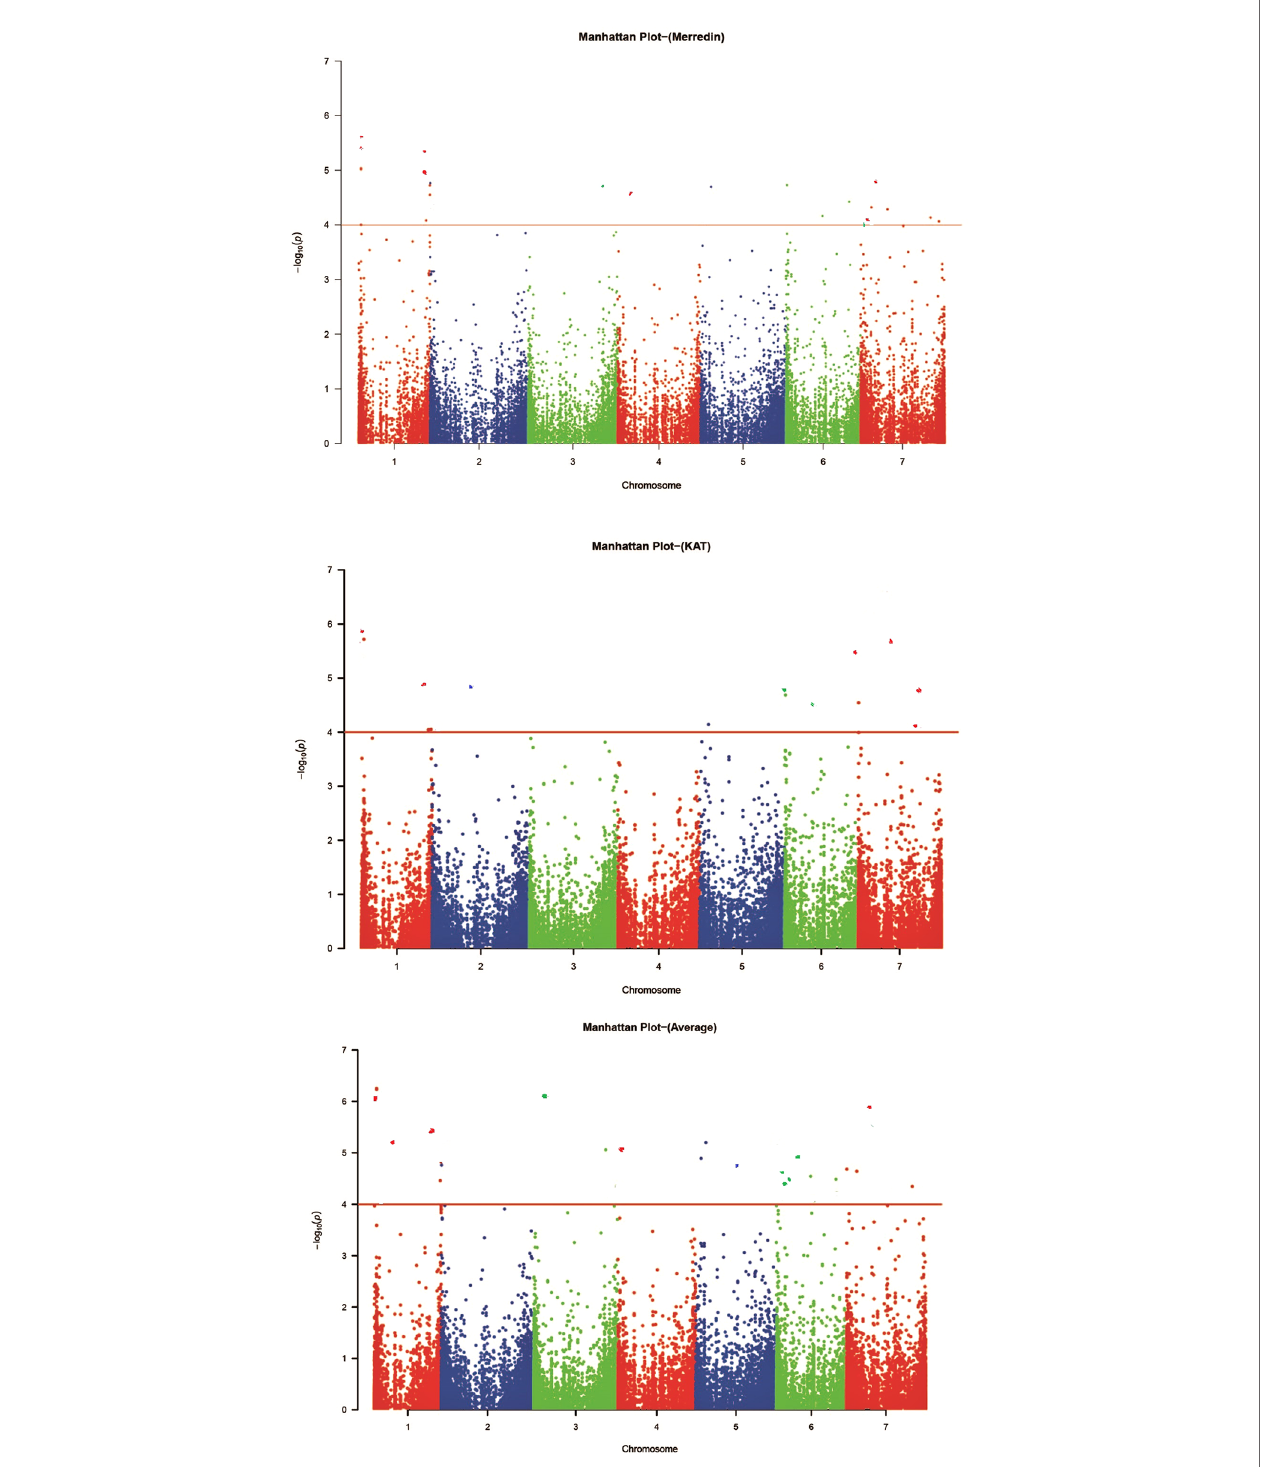
FIGURE 4 | Manhattan plots for genome-wide association study (GWAS) of 350 barley accessions grown in Merredin, Katanning, and average for salinity tolerance index during germination under 150 mM NaCl. Each color indicates a different chromosome, the Y-axis is – log (P) values, and the dots above the red line are signi fi cant markers at – log10 (P) ≥ 4.0 (Krzywinski et al.,